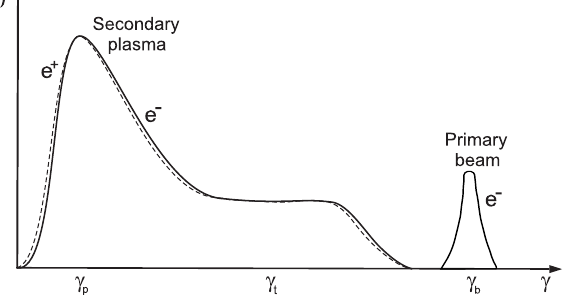
Figure 1. Distribution function for a one-dimensional electron–positron plasma of pulsar magnetosphere. The generation of t -waves occurs in the outflowing plasma on the open field lines due to instabilities developing in the outer regions of the pulsar magnetosphere. The strongest instabilities that can develop in the pulsar magnetosphere are the electromagnetic cyclotron and Cherenkov-drift instabilities. The low-frequency radio emission detected from the Crab pulsar is a core-type emission that can be excited only through the anomalous cyclotron resonance process. The resonance condition for the cyclotron instability is [31]